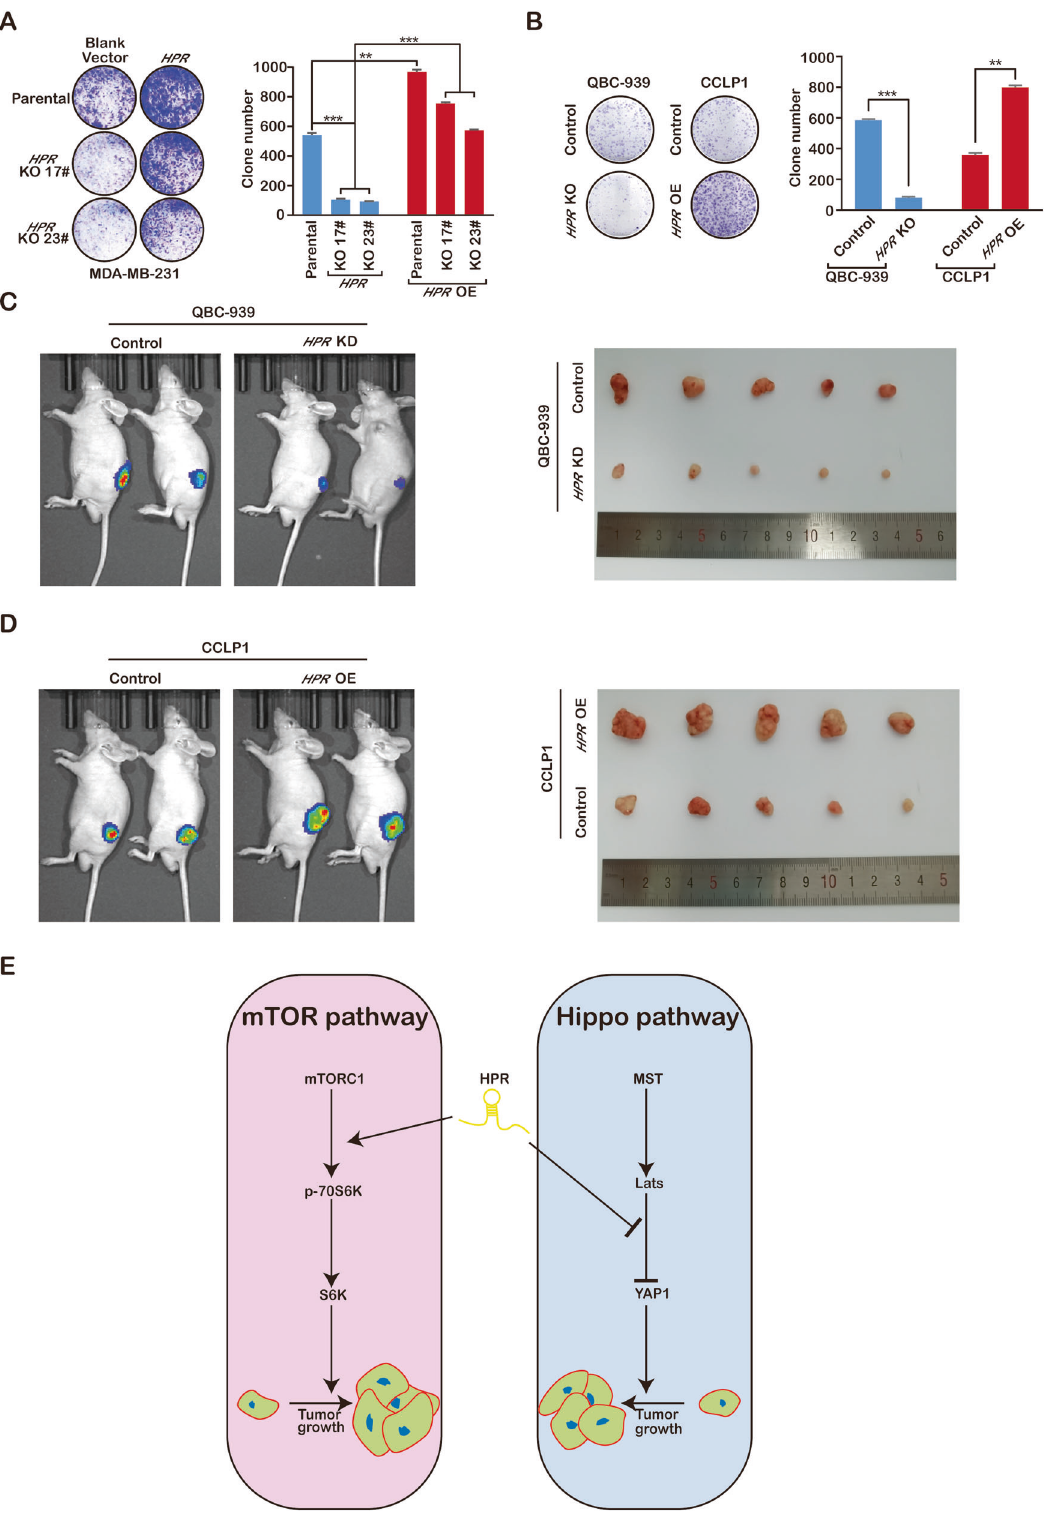
Fig. 7 HPR inhibits the growth of cancer. a Clonogenicity assay detection of the growth of HPR -knockout MDA-MB-231 cells. b Clonogenicity assay detection of the growth of HPR- knockdown QBC-939 cells and overexpressed CCLP1 cells. c In vivo analyses of tumour growth in mice that were subcutaneously injected with HPR -knockdown QBC-939 cells. d In vivo analyses of tumour growth in mice that were subcutaneously injected with HPR- overexpressing CCLP1 cells. e Graphic illustration of the functional role of HPR coordinates the activation of the Hippo and mTORC1 pathways in